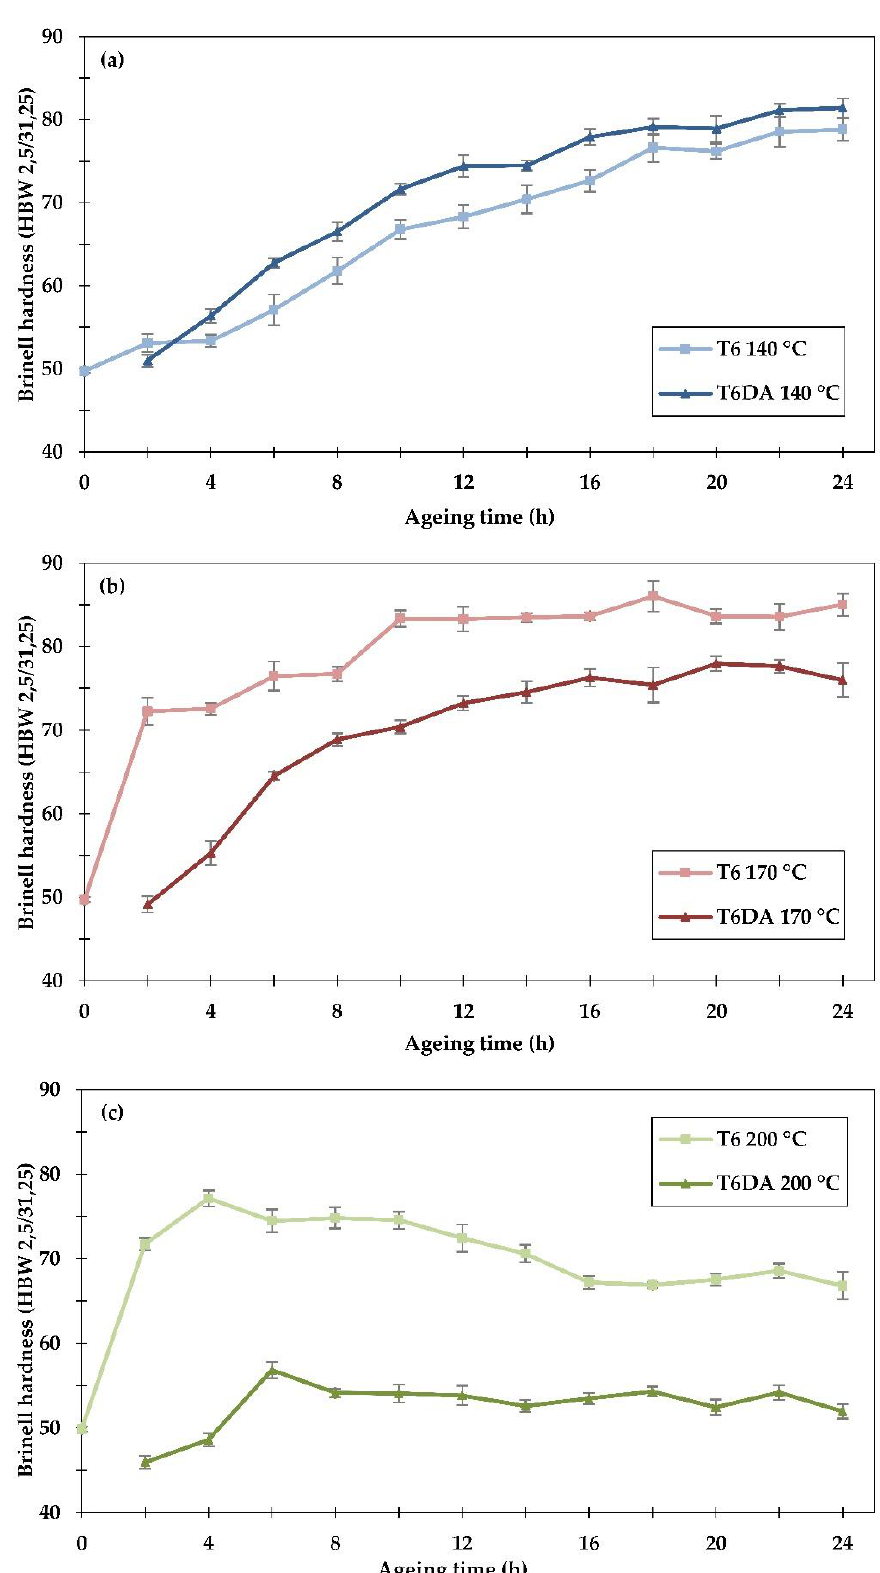
Figure 5. Brinell hardness (HBW 2.5/31.25) of the samples subjected to artificial ageing at ( a ) 140 °C, ( b ) 170 °C and ( c ) 200 °C, using two different heat treatment procedures: to the conventional T6 temper and directly to the ageing temperature.